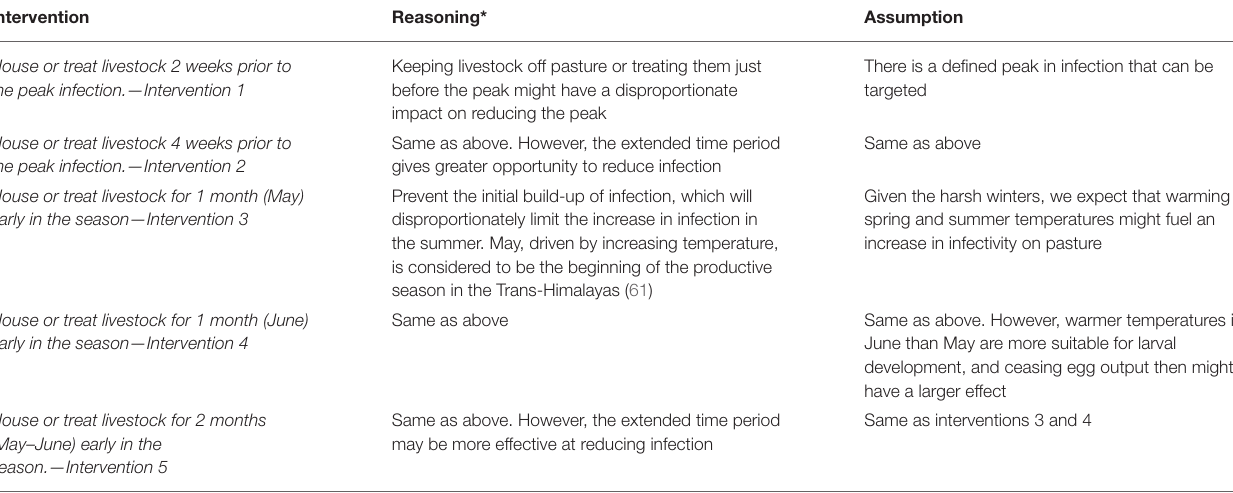
TABLE 3 | Intervention scenarios to reduce infection and align livestock and wildlife health in the Kibber grazing system.